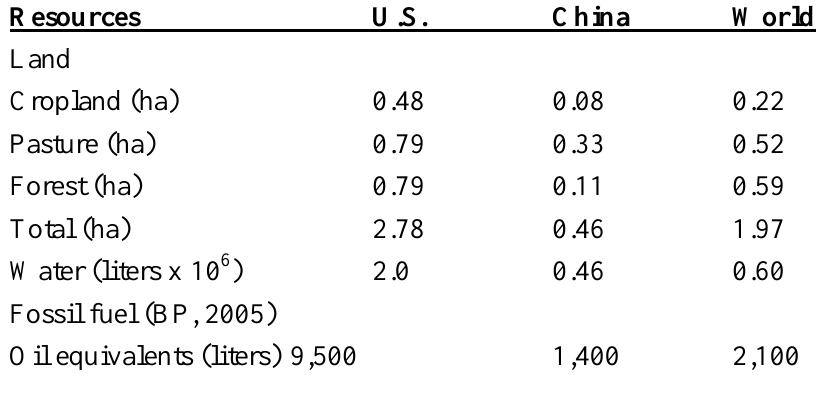
Table 1. Resources used and/or available per capita per year in the U.S., China, and the world to supply basic human needs